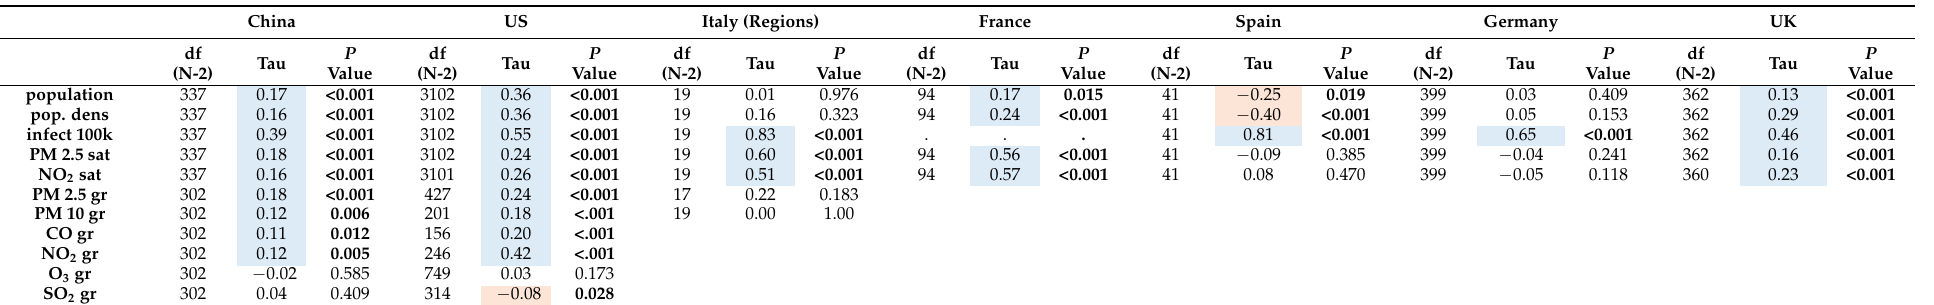
Table 3. Correlation coefficients between COVID-19 deaths per 100,000 inhabitants and air quality variables. Significant Kendall correlations with p -values < 0.05 are shown in bold; blue and red shadings indicate positive and negative correlations,